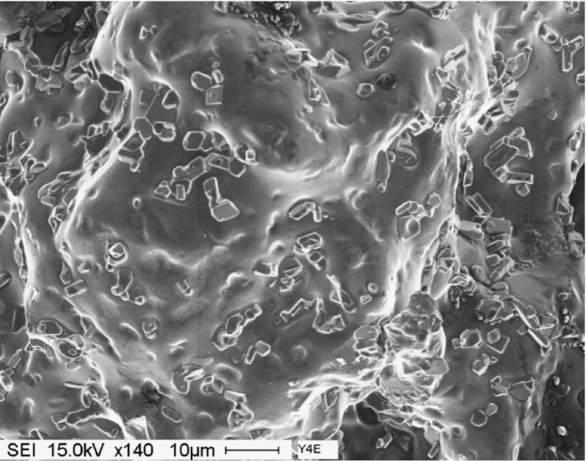
Figure 15. Secondary electron image showing the fracture surface of A1B alloy solutionized at 560 ˝ C for 12 h, DAS ~ 25 µ m.